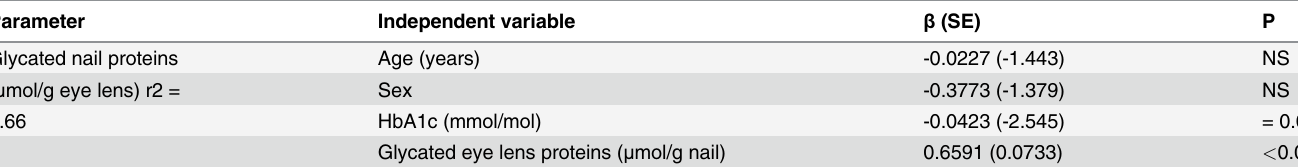
Table 1. Multiple regression model with glycated nail proteins as dependent